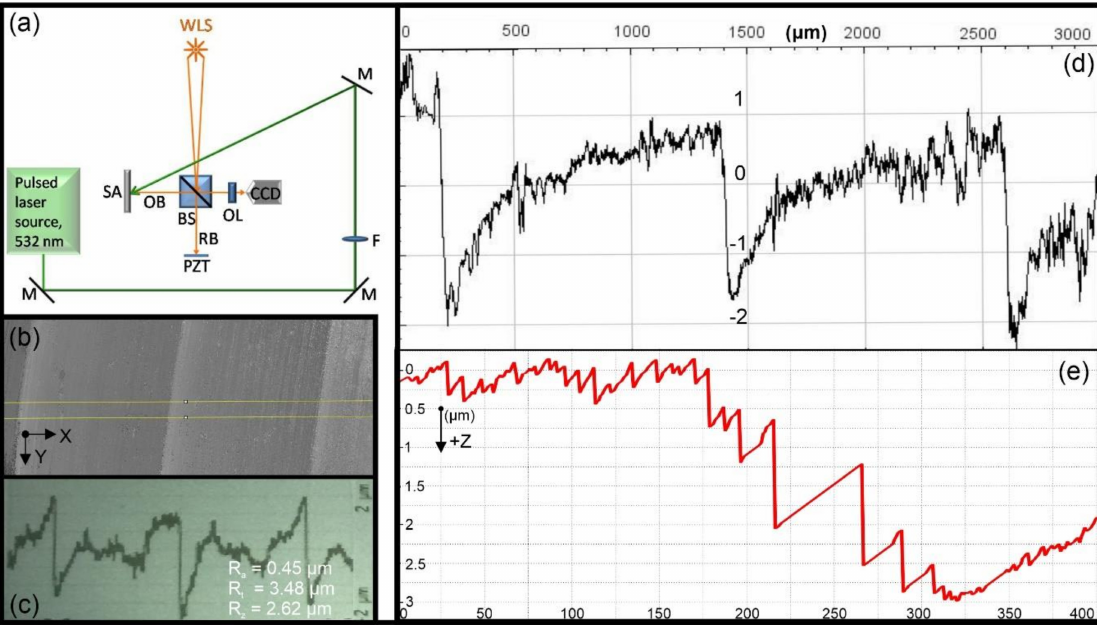
Figure 1. Optical setup and the periodic surface roughness profile. ( a ) Experimental setup for the target–laser interaction measurements: M, metallic mirror; F, converging lens with focal length f = 100 cm; SA, aluminum sample. Profilometry setup: WLS, white light source; BS, beam splitter; RB, reference beam; OB, object beam; PZT, piezoelectric transducer; OL, objective lens. ( b ) The 2D grayscale surface image of the SA as extracted from the profilometry measurements, of ~3 mm of length. ( c ) The periodic roughness profiles and the measured values of R a , R t , R z , as extracted from the Roughness gauge. ( d ) The corresponding roughness line-out plot of image ( b ) measured by the profilometry setup; the line-out refers to the marked yellow rectangular region of the image. ( e ) Average surface roughness profile of the heated area of interest of ( b